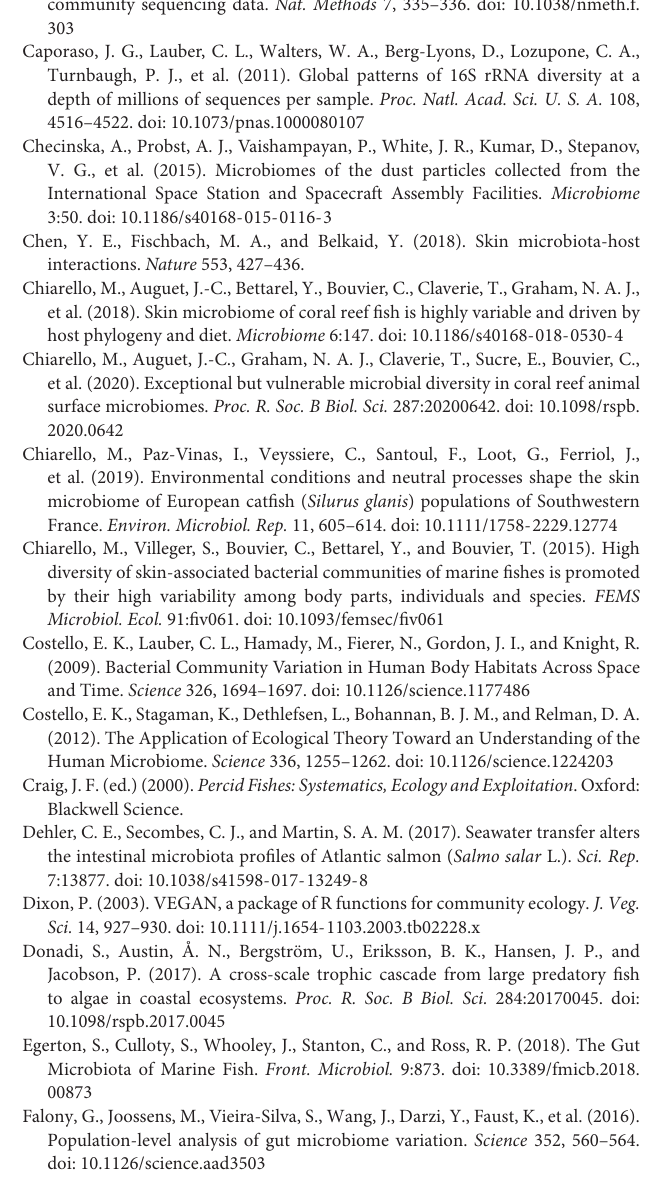
fish ∗ ] conducted on 5th of January 2021 yielded 7,299 publications indicating that scientific output on fish skin-associated microbiomes is limited but growing by each year. Supplementary Figure 2 | Rarefaction curves for fish skin-associated microbiomes and bacterioplankton communities in water samples. Curves display a sufficient sequence coverage. Supplementary Figure 3 | PCA plot based on model output from rda analysis on population differences. All 110 samples are represented. Different colors represent individual ( n = 39) and shape population affinity (triangles = Kalmar, circles = Figeholm). The plot is based on the output from the rda analysis with population as constraining variable. Supplementary Data File 1 | ASV-table and taxonomy. Supplementary Data File 2 | R-code for data processing, analysis and